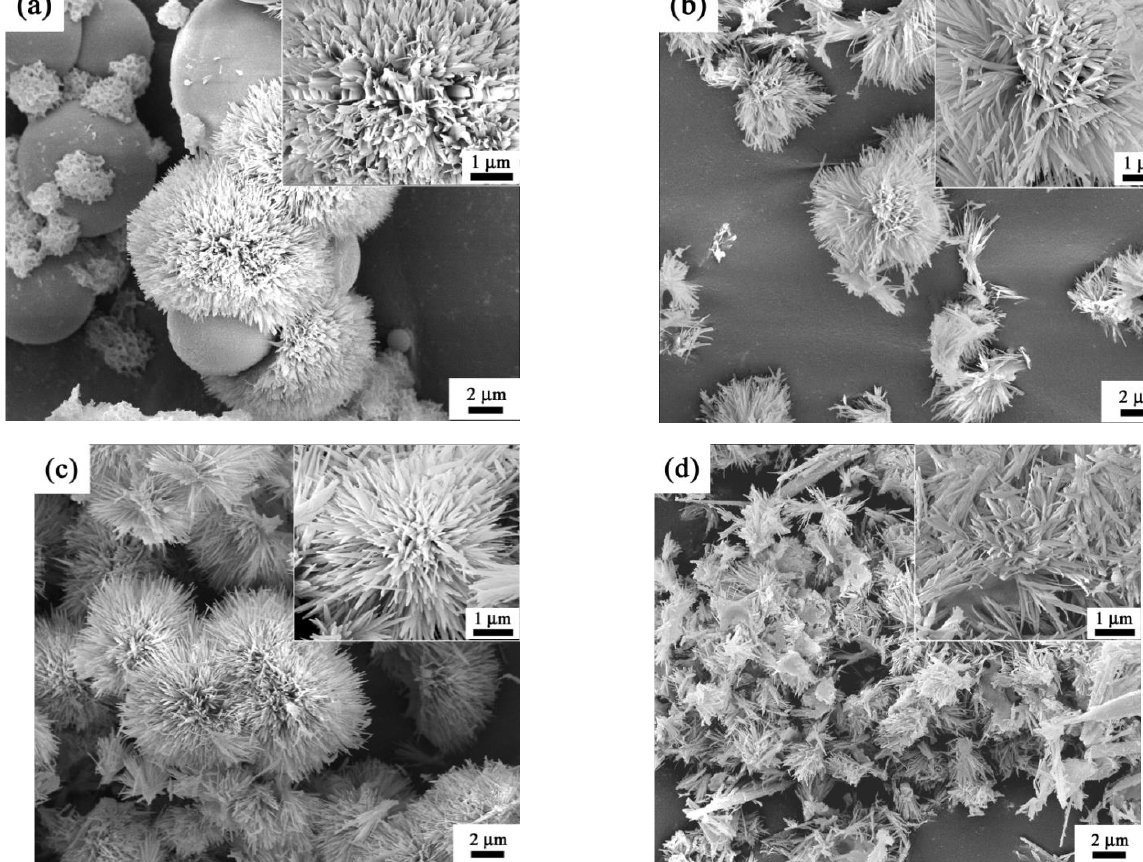
Figure 2. Scanning electron microscope (SEM) images of deposited precursors prepared by the hydrothermal method with different molar ratio of Al 3+ :CO(NH 2 ) 2 : ( a ) 1:3, ( b ) 1:5, ( c ) 1:6 and ( d )